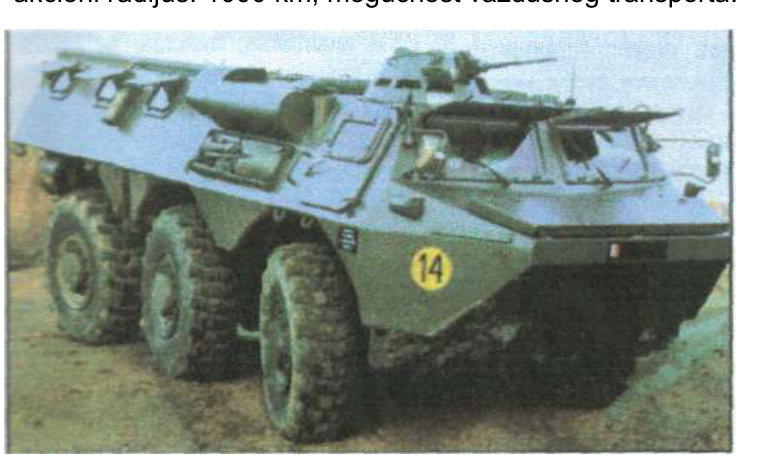
Figure 7 – French Armoured Fighting Vehicle „VAB ARS” Francuska univerzalna skela